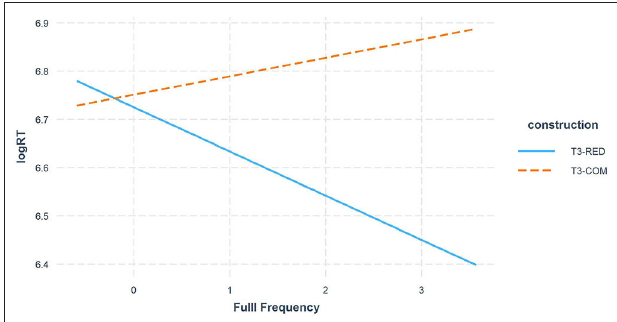
FIGURE 5 | Full Frequency effect in T3-RED vs. T3-COM